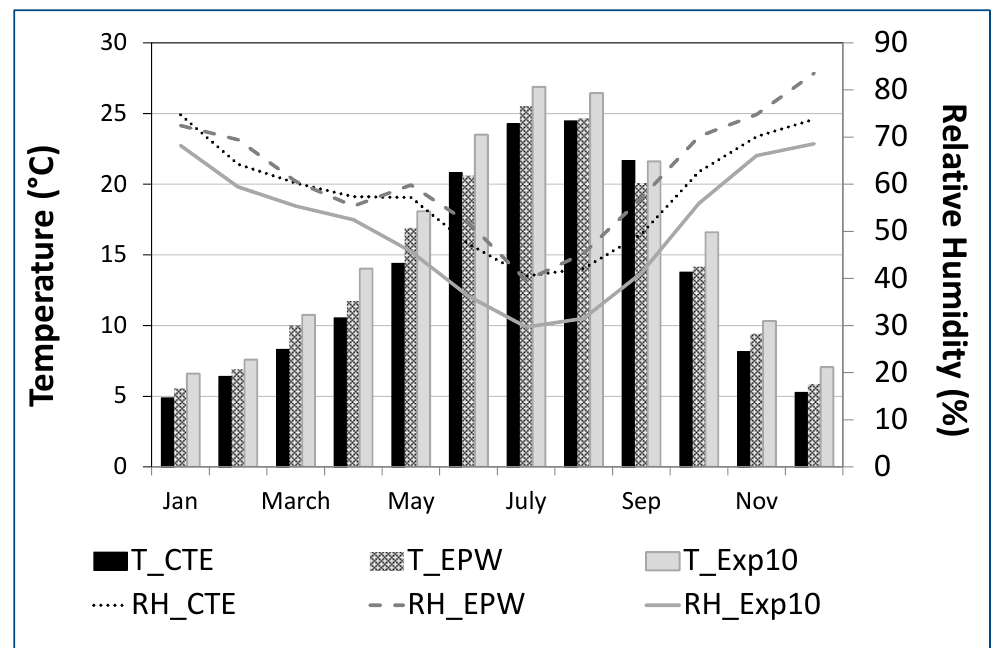
Figure 1. Annual evolution of Temperature (T) and Relative Humidity (RH) obtained for the three climate databases of Madrid: CTE, EPW, and Exp10.